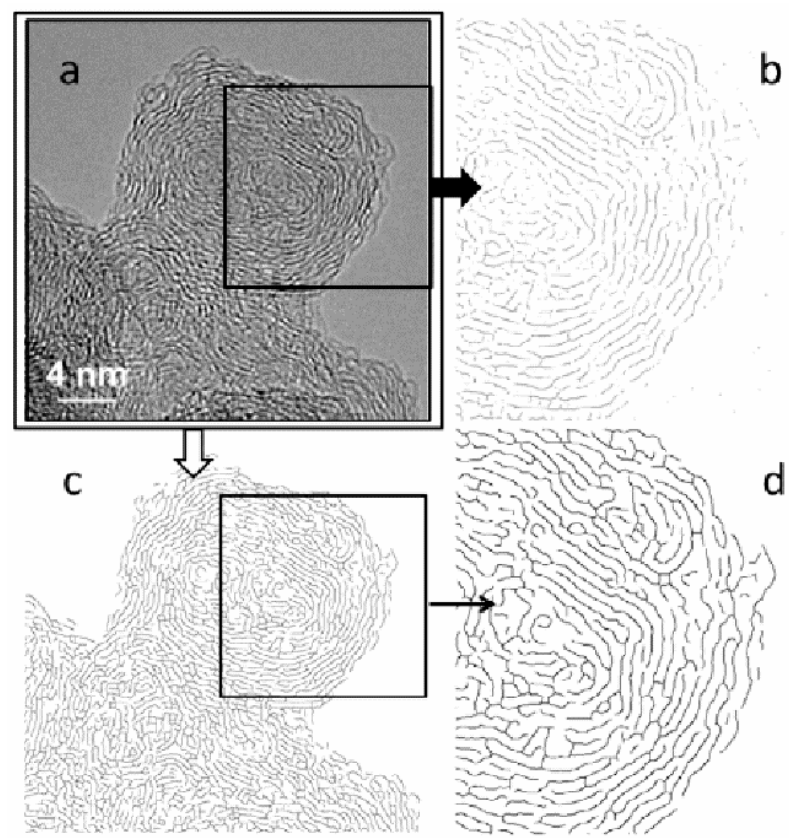
Figure 10. Quantitative analysis of carbon layers distribution in soot. ( a ) HRTEM image of mature benzene soot. ( b ) The skeletonized image by Analyze Plan. ( c ) Morphological analysis. ( d ) Magnification of the part of the analysed HRTEM image (14 nm × 14 nm) with enhanced contrast of carbon layers. Reproduced with permission from Apicella et al. [54]. Copyright Elsevier, 2015.